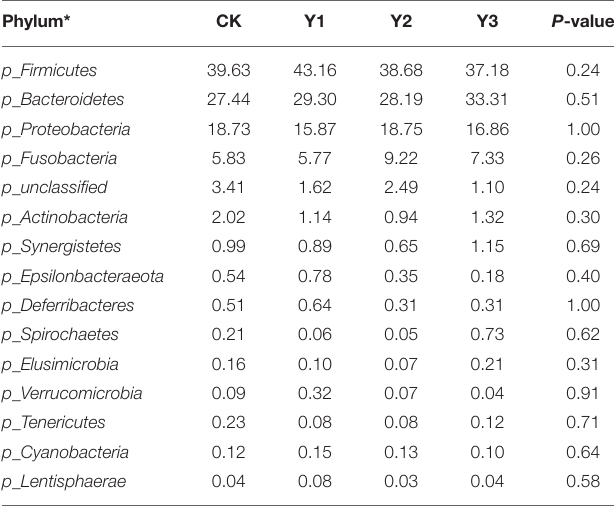
TABLE 3 | Effects of dietary AOE on phylum-level relative abundances of the cecal microbiota in ducks (%).